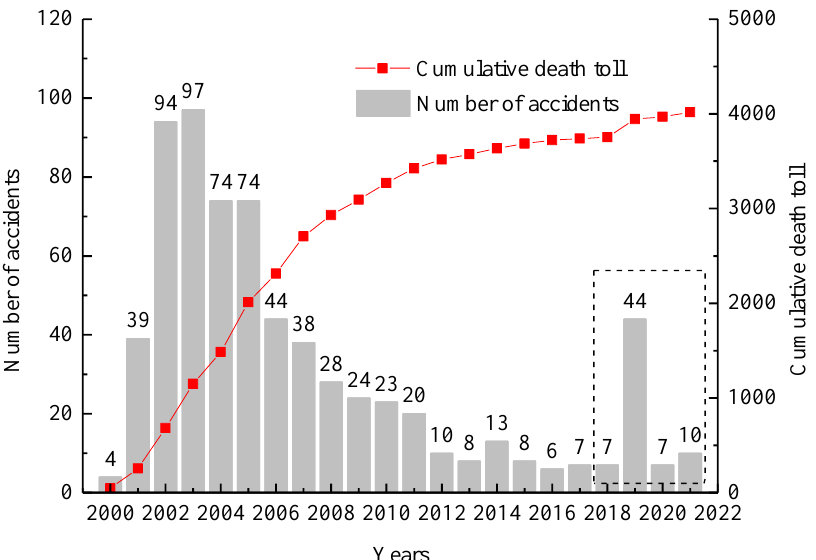
Figure 1. Water-related mining accidents in China from 2000 to 2021.